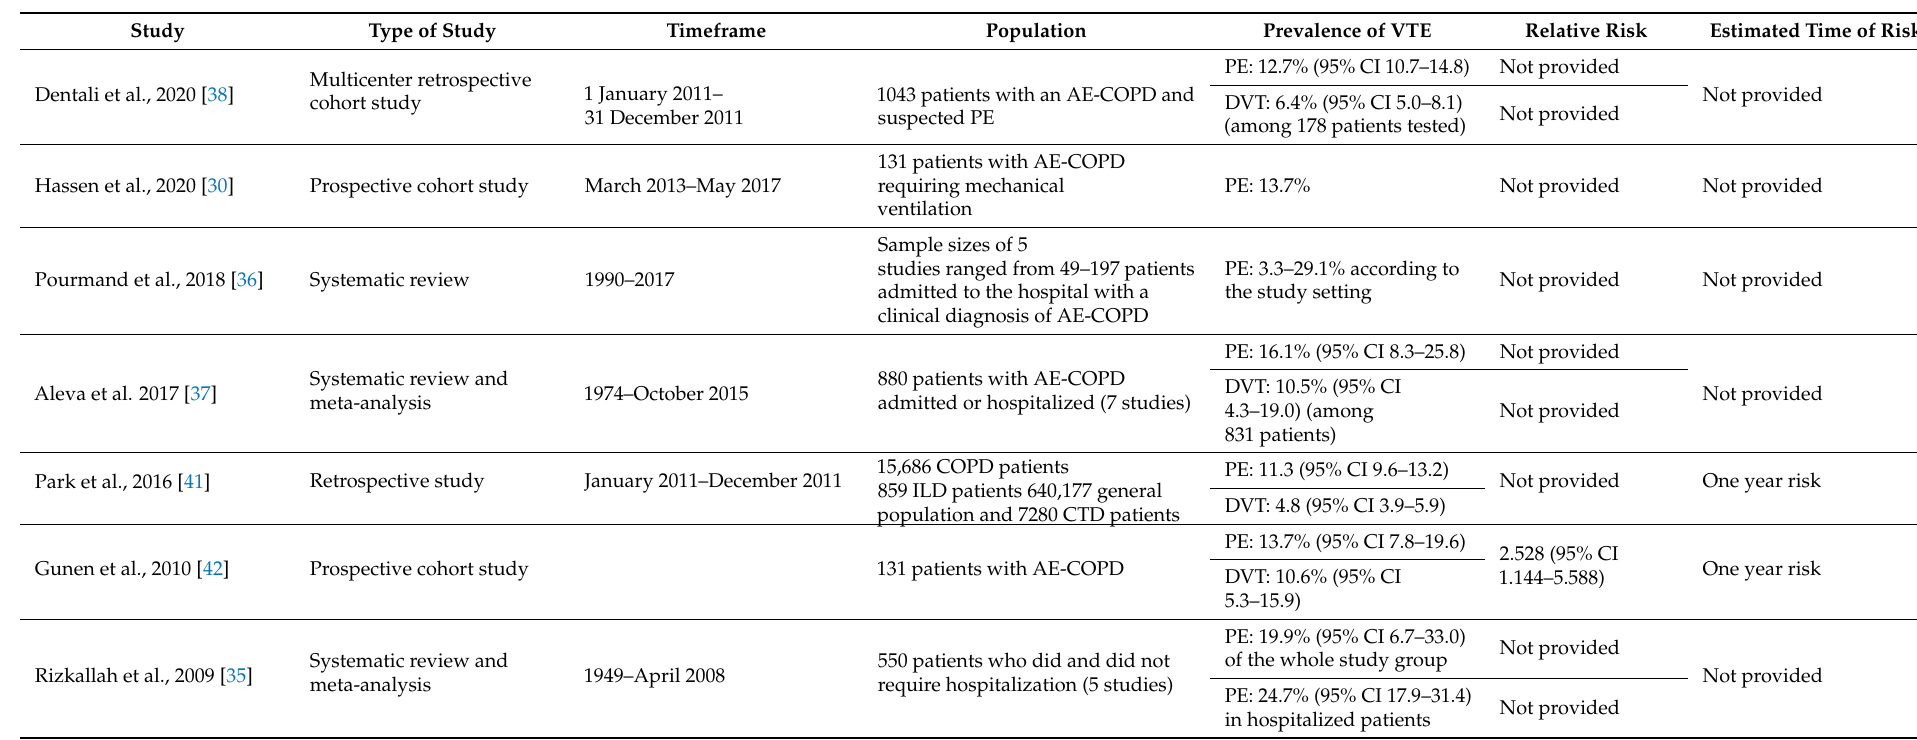
Table 2. Characteristics of studies included in this review regarding the relationship between chronic obstructive pulmonary disease (COPD) and venous thromboembolic disease (VTE).